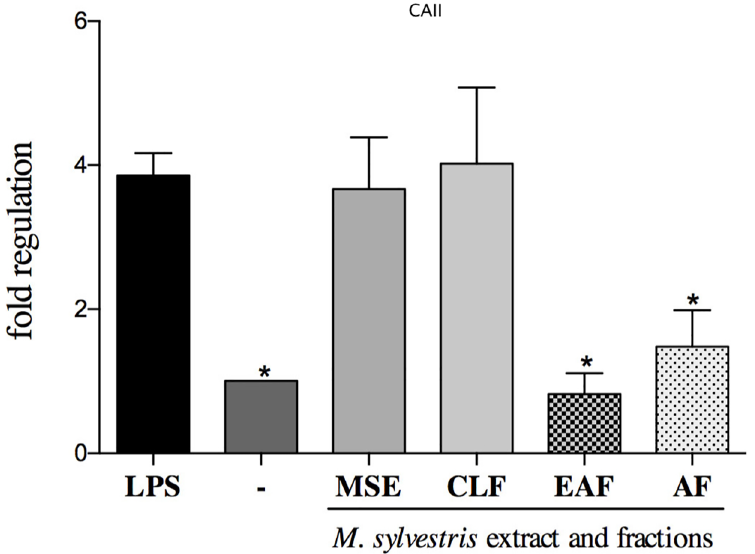
Fig 4. Effect of MSE and fractions on CAII (carbonic anhydrase II) expression levels. Quantification of the relative transcript amounts performed by qpcR with 10 ng of each cDNA. Data quantification was performed using 2(-DeltaDeltaC(T)). Statistical analyses were performed by one-way ANOVA followed by Dunnett ’ s post-hoc tests. * p < 0.05 significantly different from LPS-stimulated cells.